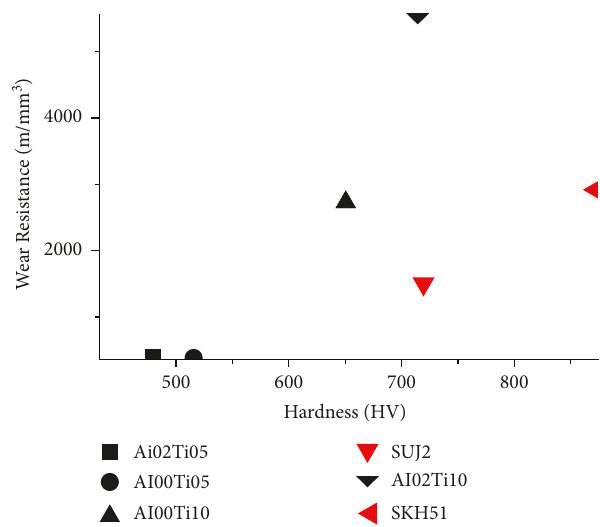
Figure 22: Variation in Adhesive wear behaviour and microhardness of various HEAs [33].